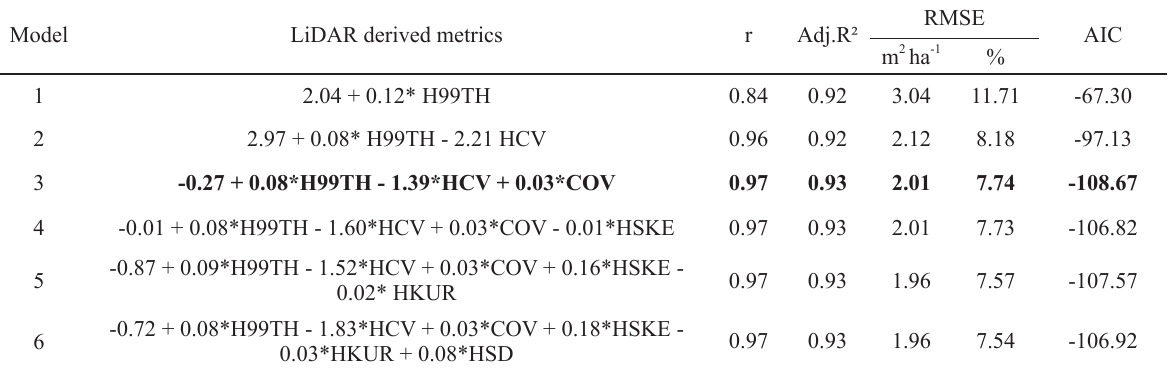
LiDAR-derived models for predicting BA (natural-logarithm transformed) in P. taeda plantations. Pearson’s correlation (r), Adjusted coefficients of determination (adj.R²), root mean square error (RMSE) and corrected Akaike information criterion (AICc). Bold values represent the best